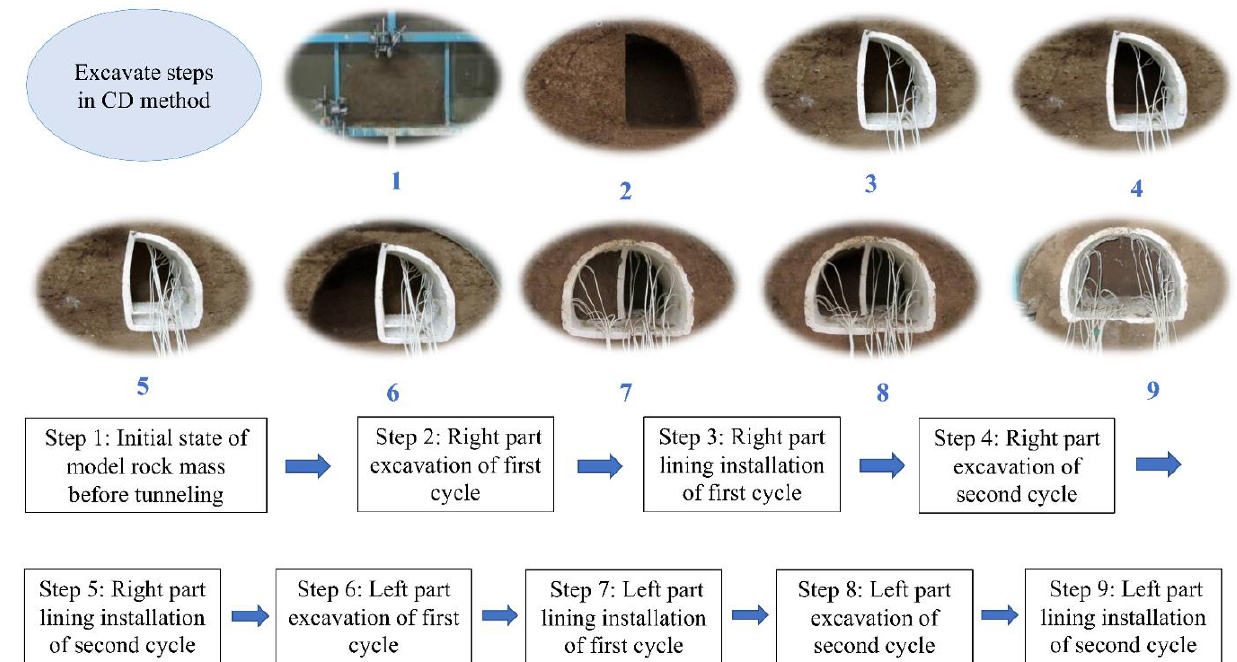
Figure 9. Excavation steps in the CD method.